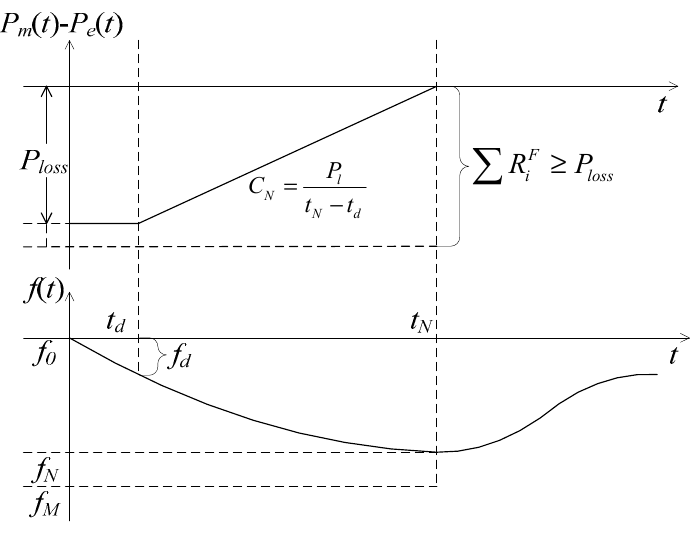
Figure 1. Governor Figure 1. Governor Model.